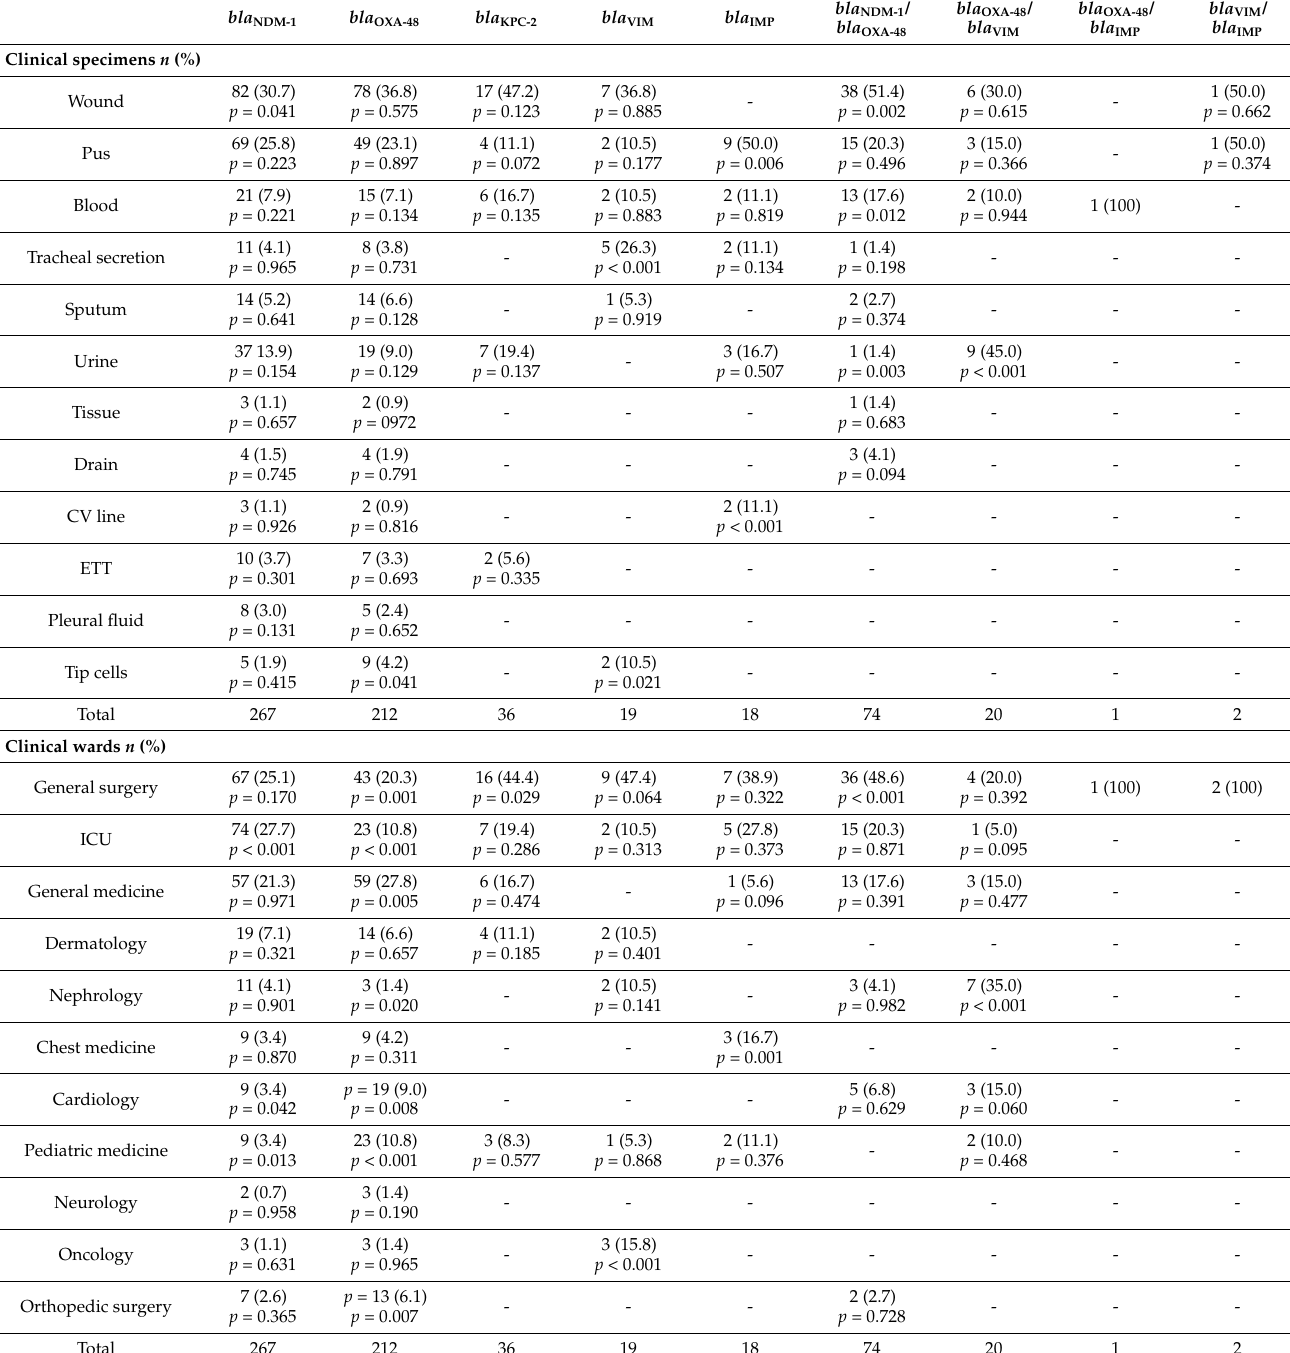
Table 5. Distribution of carbapenemases among clinical specimens and